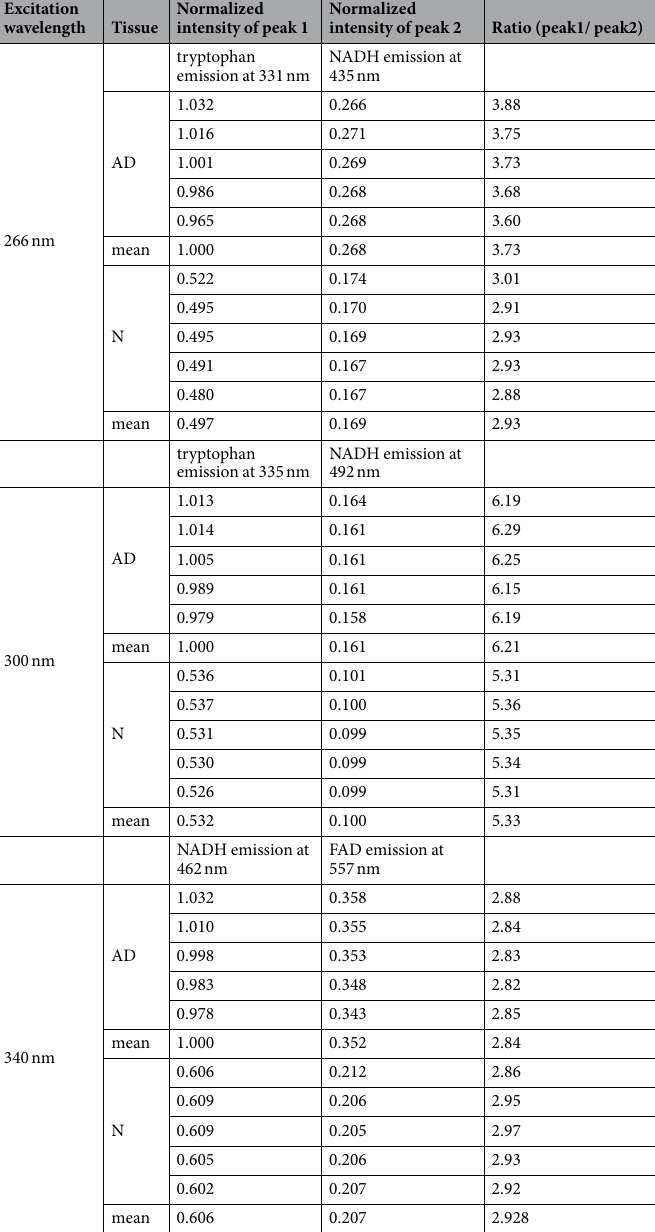
Table 1. Emission peaks in AD and N brain samples. AD: Alzheimer; N: